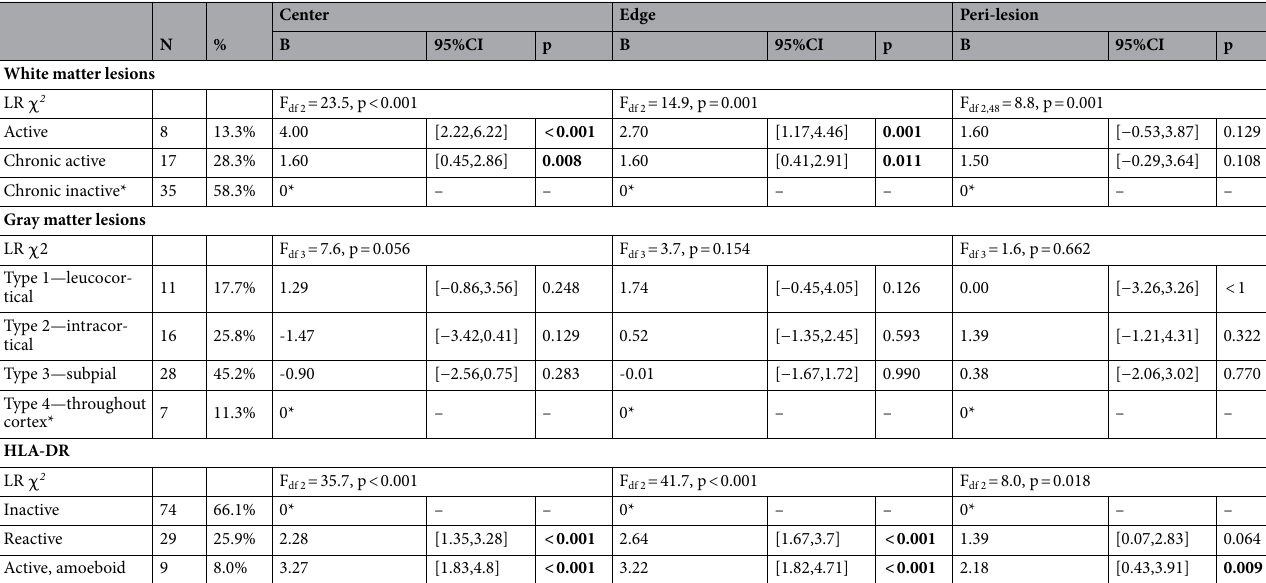
Table 5. Multinominal linear regression analyses of LGMN score by lesion type and HLA-DR. B coefficient, CI confidence interval, * reference category, LR χ 2 loglinear chi square, Df degrees of freedom. Significant p-values after sequential Bonferroni correction indicated in bold